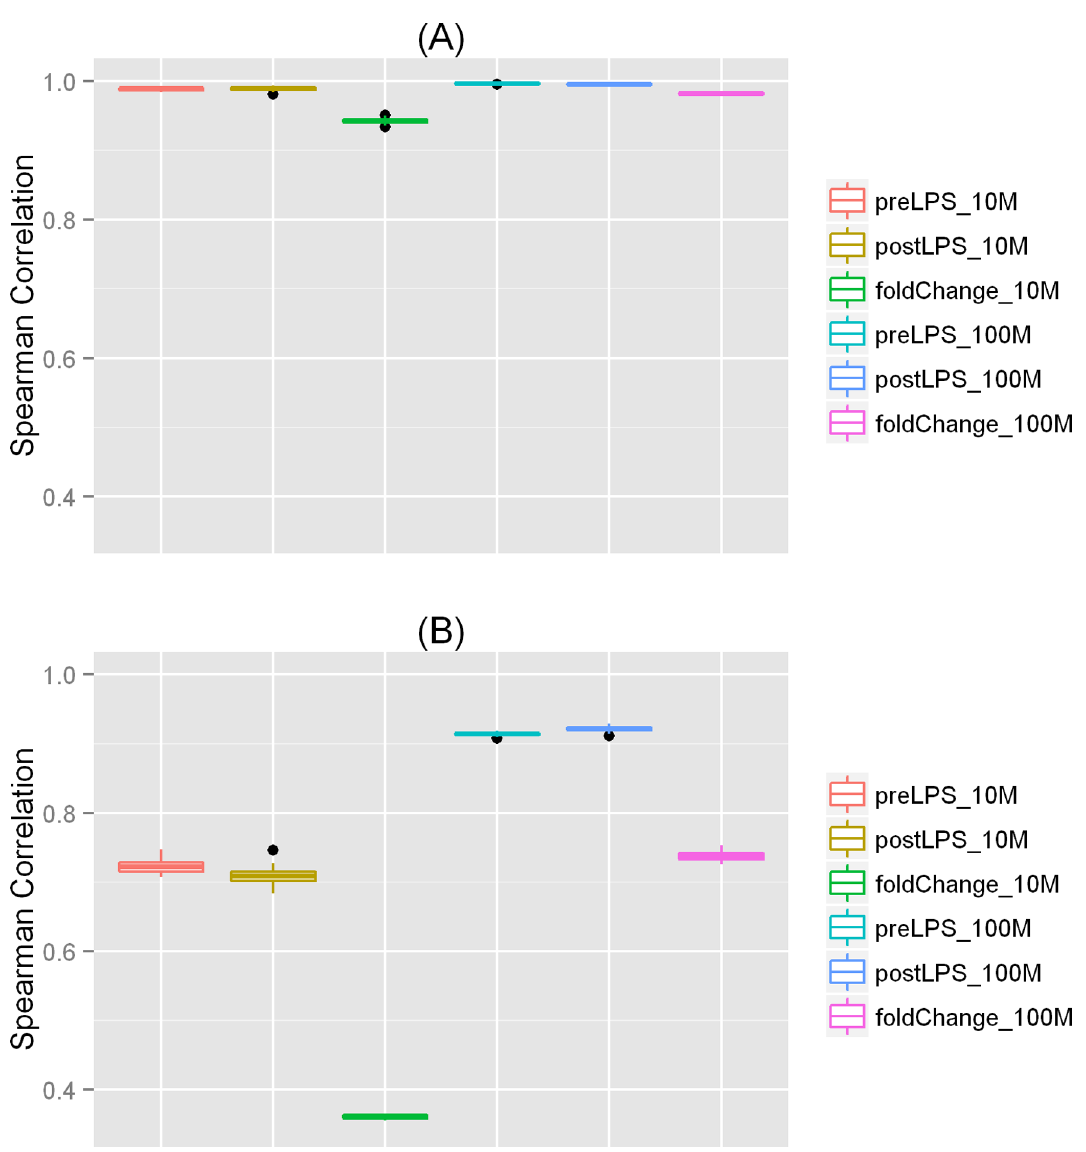
Figure 3. Spearman correlation boxplot for randomly simulated datasets. ( A ) Boxplot of Spearman correlations for FPKM values and fold change of FPKM values among 10 randomly sampled datasets. For each sequencing depth (10 M or 100 M), the correlation was calculated for each of the 45 pair-wise comparisons. ( B ) Boxplot of Spearman correlations for exon/intron inclusion levels and fold change of inclusion levels among 10 randomly sampled datasets. For each sequencing depth (10 M or 100 M), the correlation was calculated for each of the 45 pair-wise comparisons. doi:10.1371/journal.pone.0066883.g003 Table 2. Numbers of expressed genes, differentially expressed (DE) genes, alternative splicing (AS) events and differential AS (DAS) events detected in the technical replicate samples and the resampled data with the same sequencing depth* as the technical replicate.